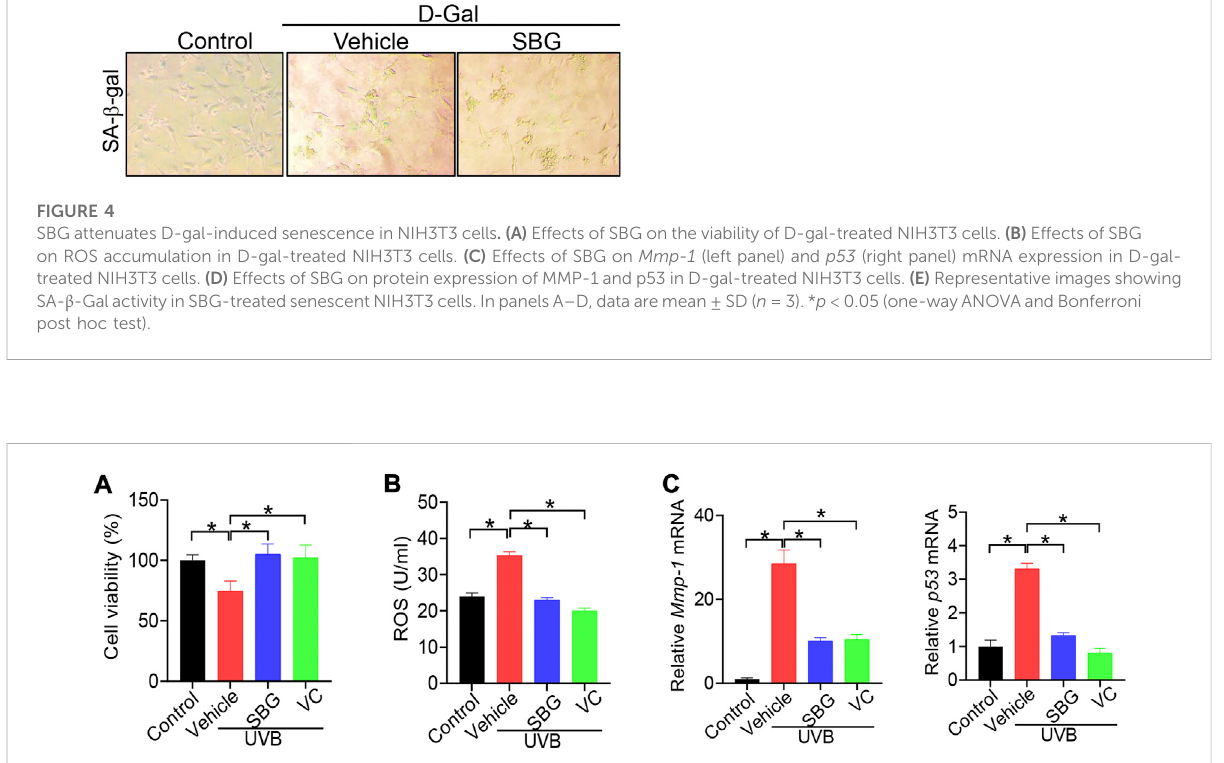
FIGURE 5 SBG attenuates UVB-induced senescence in HaCaT cells . (A) Effects of SBG on the viability of UVB-treated HaCaT cells. (B) Effects of SBG on ROS accumulation in UVB-treated HaCaT cells . (C) Effects of SBG on the mRNA expression of Mmp-1 and p53 in UVB-treated HeCaT cells. Data are mean ± SD ( n = 3). * p < 0.05 (one-way ANOVA and Bonferroni post hoc